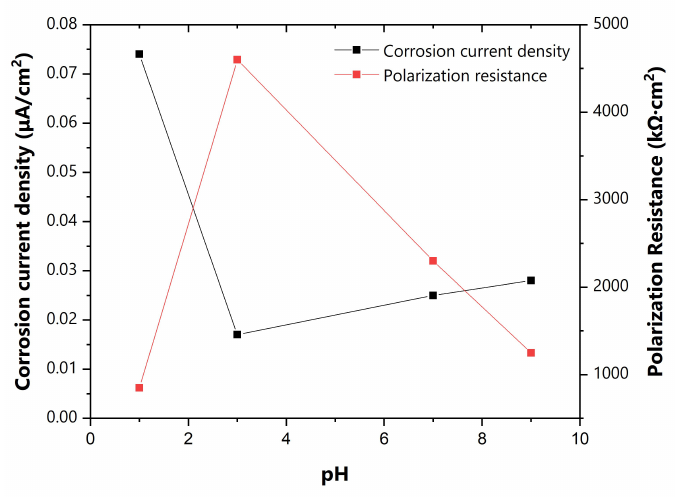
Figure 10. Corrosion current density and polarization resistance of HEA TiZrNbTaMo after 24 h exposure in Ringer’s solution. Based on